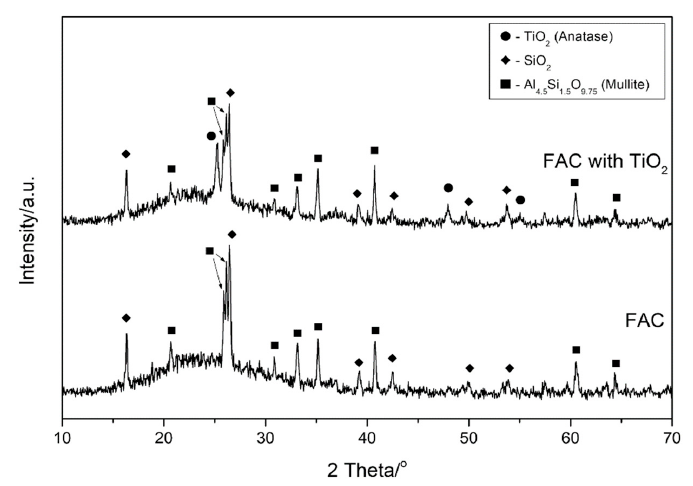
Figure 5. Di ff ractograms of fly ash cenospheres (FAC) and FAC with TiO 2 coating. Figure 5. Diffractograms of fly ash cenospheres (FAC) and FAC with TiO Figure 5. Diffractograms of fly ash cenospheres (FAC) and FAC with TiO 2 coating.